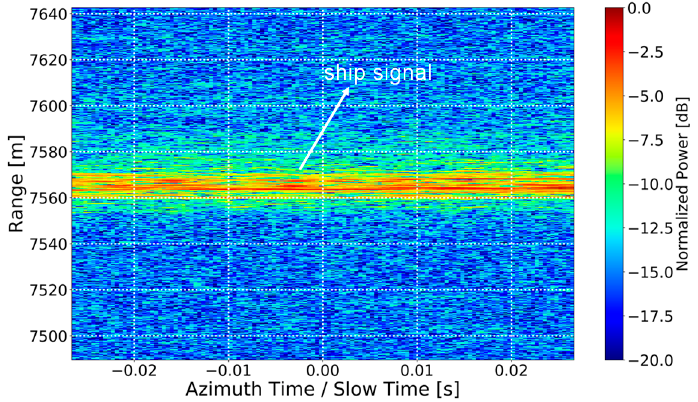
Figure 5. Patch of HH polarization X-band F-SAR data containing a ship target (at a range of approx. 7570 m). For visualization purposes, the data were normalized to the maximum power.